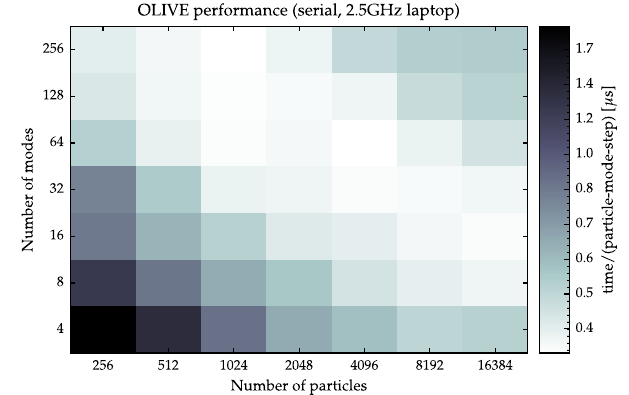
FIG. 6. Timings for a single step weighted per particle and per mode are shown for upwards of 256 modes and 12800